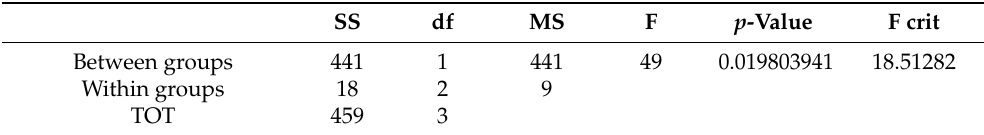
Table 2. Results of the one-way ANOVA carried out on the sightings of bottlenose dolphins. It compares sightings with fishing boats interactions to those in which no interaction was observed. SS df MS F p -Value F